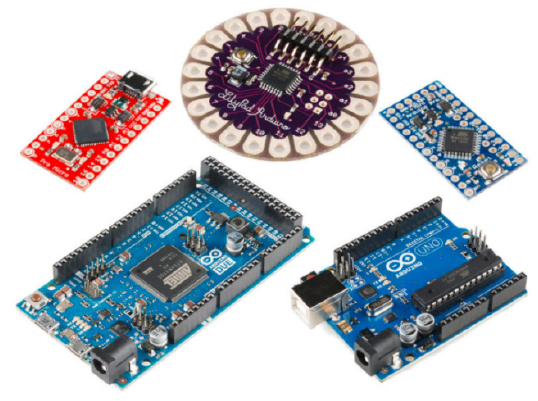
Fig. 4. Types of Arduino boards [2]